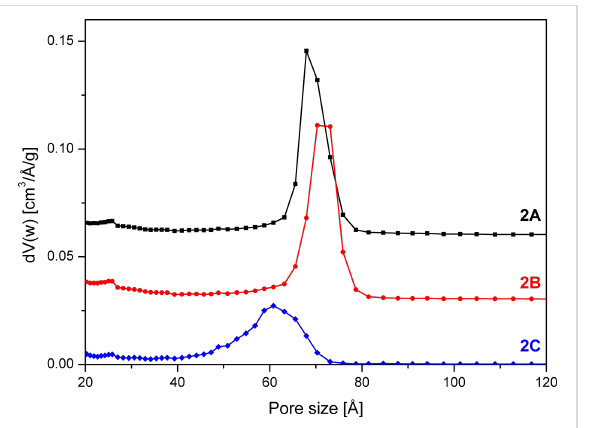
Figure 6: NLDFT pore size distribution of SBA-15 unwashed ( 2A ), after washing with 5 mL ( 2B ) and 30 mL ( 2C ) quantities of solvent calculated from the desorption branch of the isotherm. The pore size distributions are offset by 0.5 ( 2A ) and 0.25 ( 2B ) cm 3